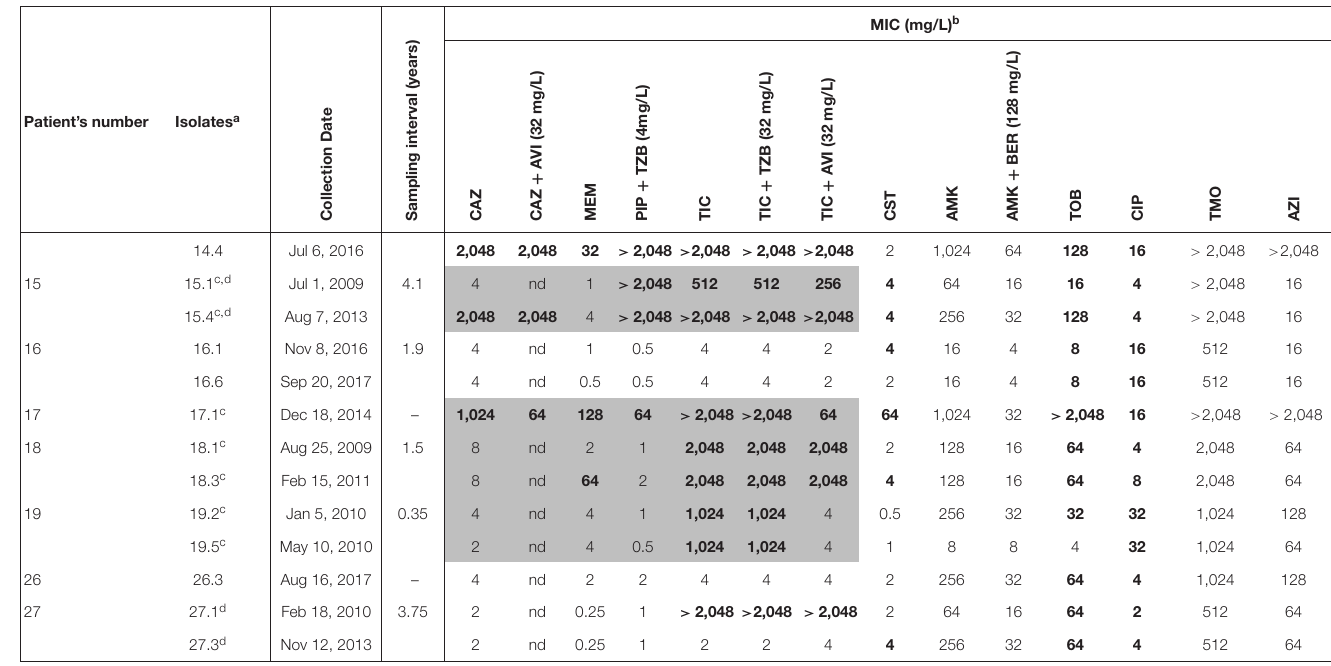
a Strain numbering: first figure corresponds to the patient; second figure correspond to the isolate number in each patient (late isolate collected over the period of sampling). b Values in bold are above the CLSI breakpoint (when available; see Table 1 for values). c Gray background highlights MICs of strains in which cephalosporinase activity was phenotypically detected. d A.